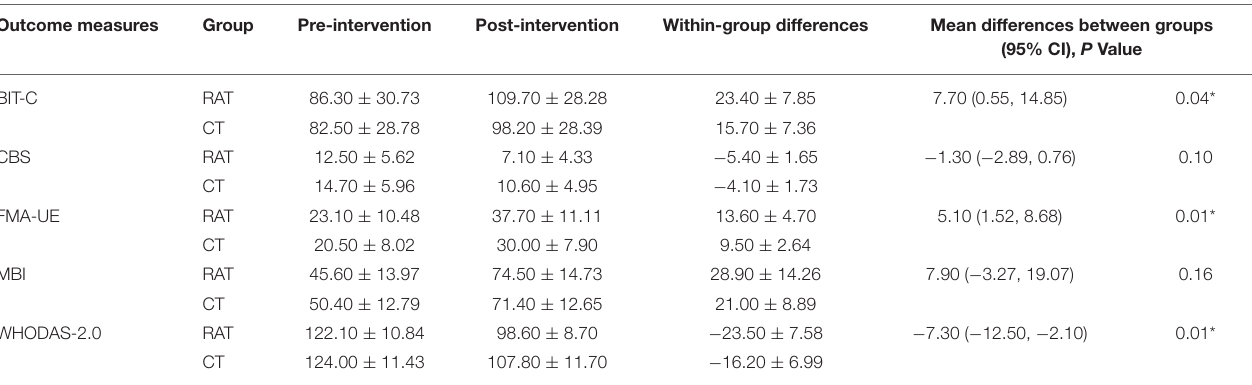
TABLE 2 | Outcome measures for the RAT ( N = 10) and CT ( N = 10)